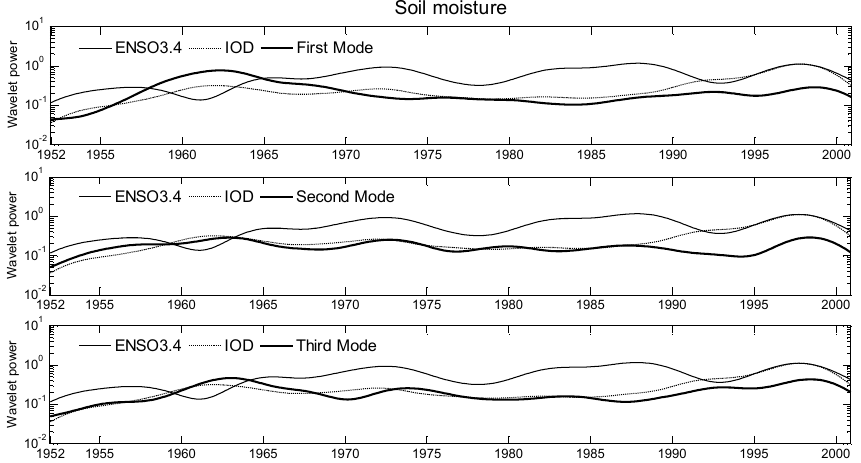
Fig. 10. Comparison of the scale-averaged wavelet power for runoff and selected climate indices for the dominant low-frequency variability band 0.83–5.21 yr.